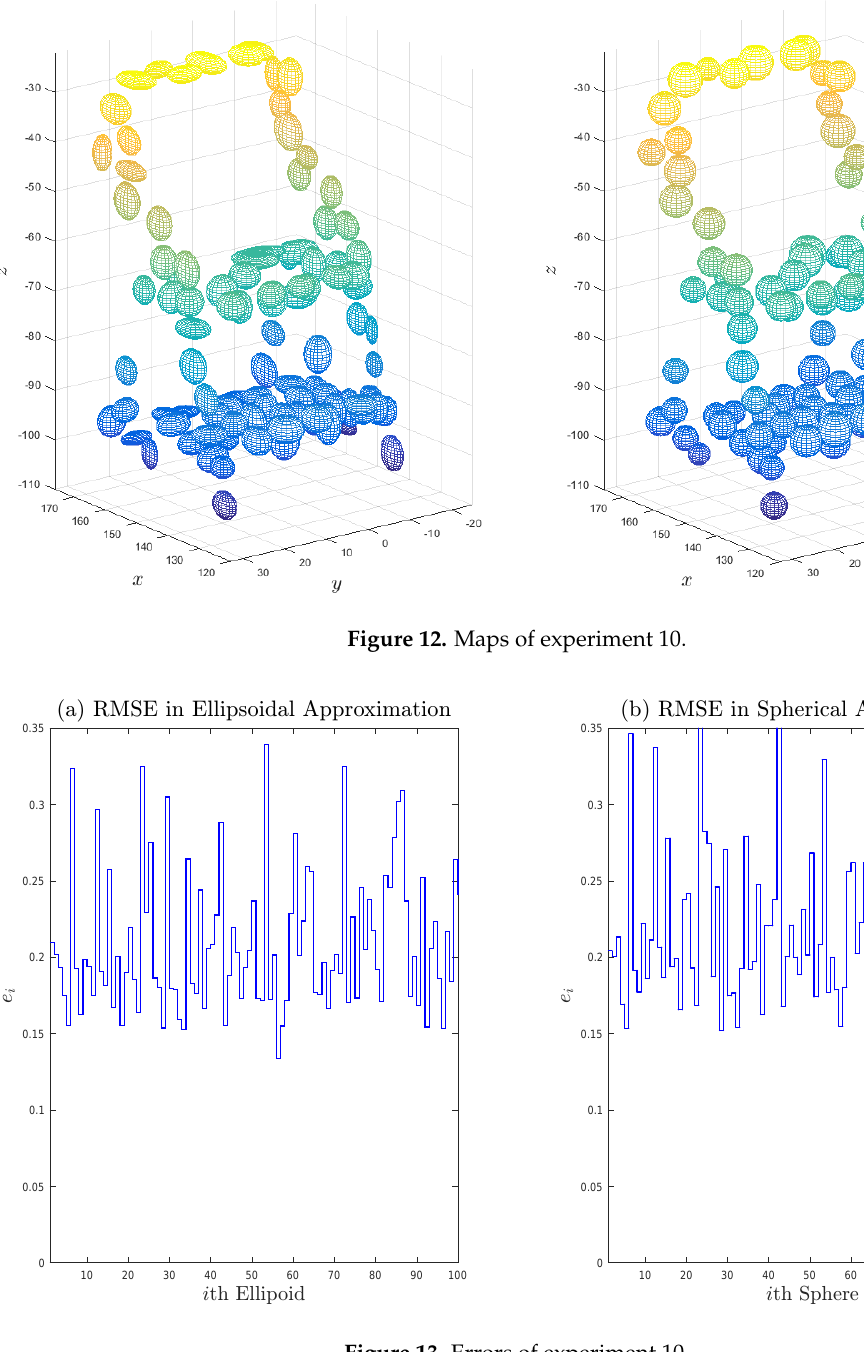
Figure 13. Errors of experiment 10. Table 4. Errors of ellipsoidal and spherical